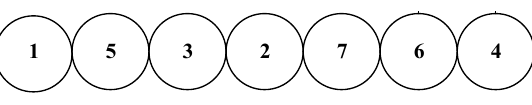
Figure 1. A sample chromosome.